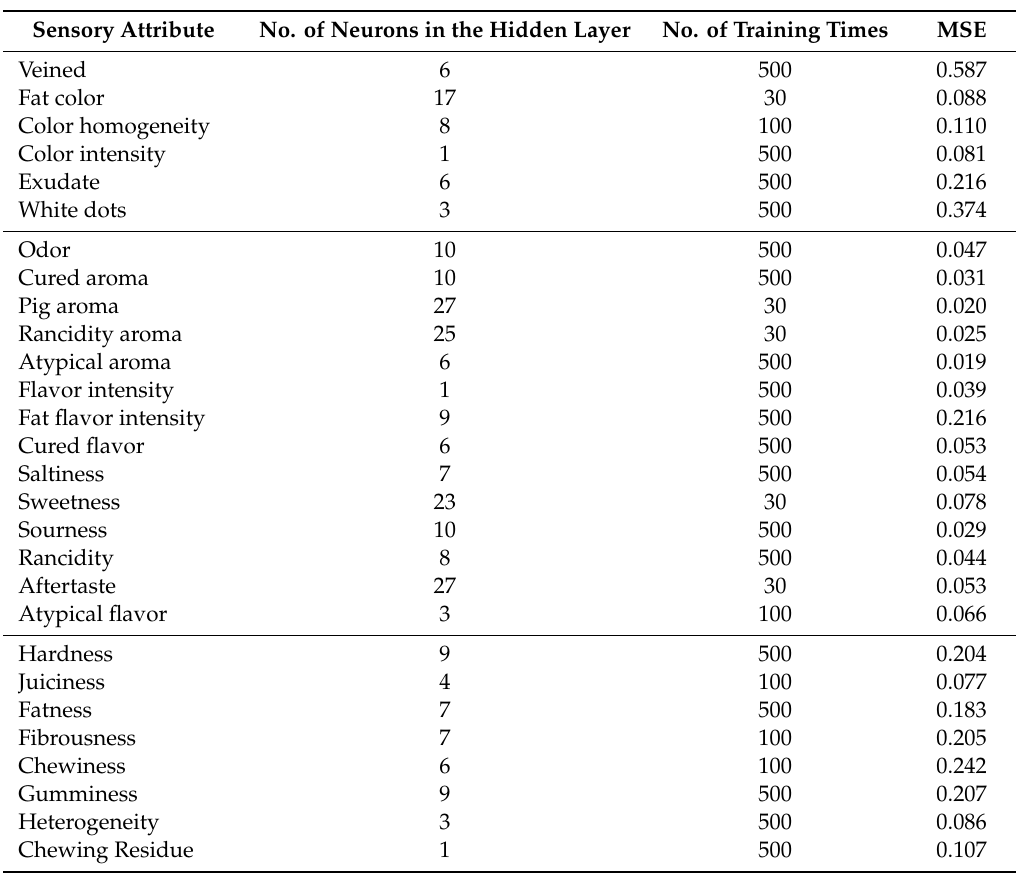
Table 5. The best ANN architecture and the mean square error of prediction (MSE) for each of the sensory parameters, obtained in the test